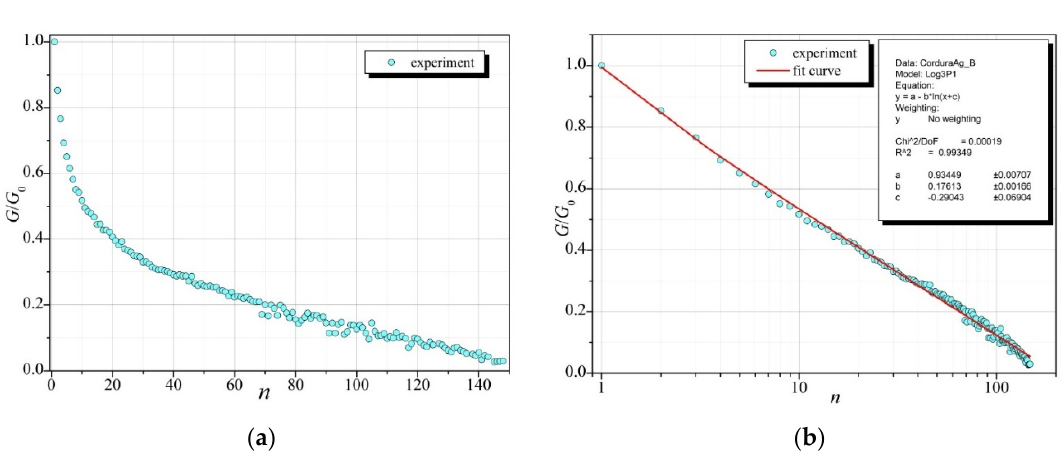
Figure 9. The ratio of conductivity of the silver layer (Ag on Cordura) with defects to the conductivity of the sample without defects depending on the number of bends with respect to ( a ) the results of the experiment; ( b ) fitting with a logarithmic function (6). The inset in the Figure 9b shows the values of parameters a , b , and c and statistical parameters (Chi 2/ DoF—Test Chi 2 /Degrees of Freedom, R 2 —coefficient of determination) determining the degree of matching, calculated using the OriginPro7 program (at the confidence level of 0.95).